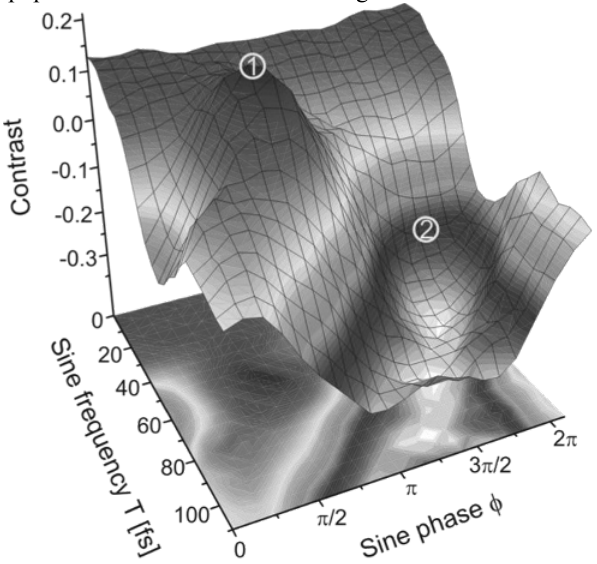
Fig. 2. Three-dimensional contrast landscape as it results from systematic variation of the sine- frequency T and the sine-phase Φ. The sine-amplitude A was set to 0.8 rad. The landscape shows high contrast variations and particularly exhibits a distinct, isolated maximum around T=50 fs and Φ =1.8 rad. At this point the modulated pulse excites the upper target channel with higher selectivity than the unmodulated pulse (T=0). Keeping T fixed a pure phase variation of Δ Φ =π switches the population transfer in the molecule to the lower electronic target channel, as observed at Φ =4.8